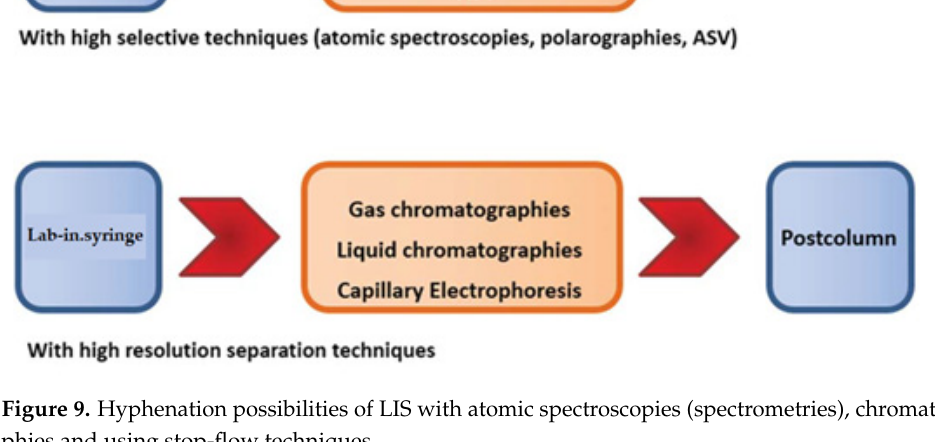
Figure 10. Coupling a multisyringe burette using a relay as an interface connected to the event input of another instrument. The procedure to operate with this hyphenated system is the following: 1.